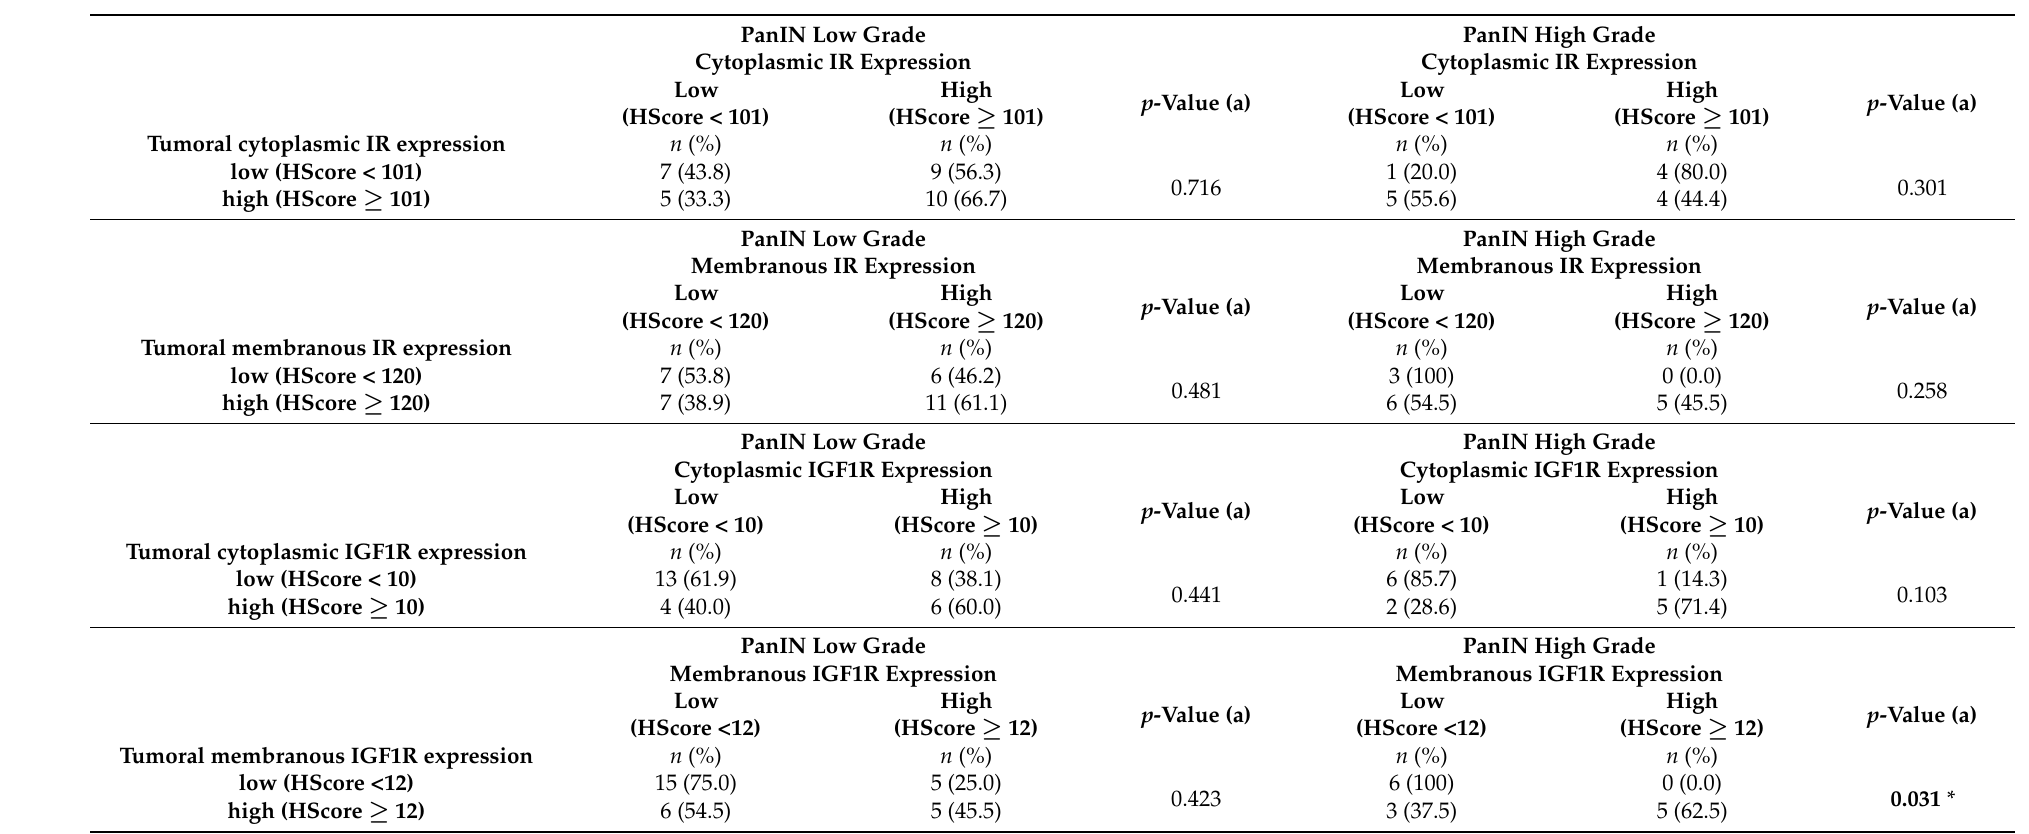
Table 4. Comparison of insulin receptor (IR) and IGF1 receptor expression between pancreatic cancer samples and corresponding intratumoral PanIN